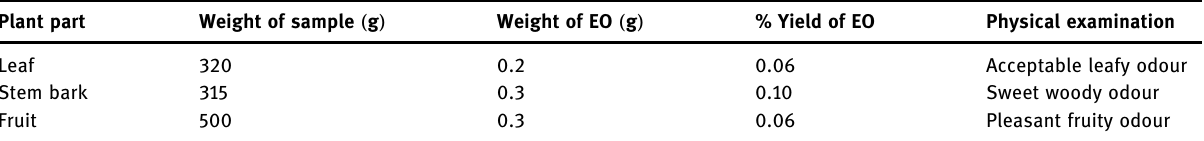
Table 4: EOs collected from D. guineense Plant part Weight of sample ( g )